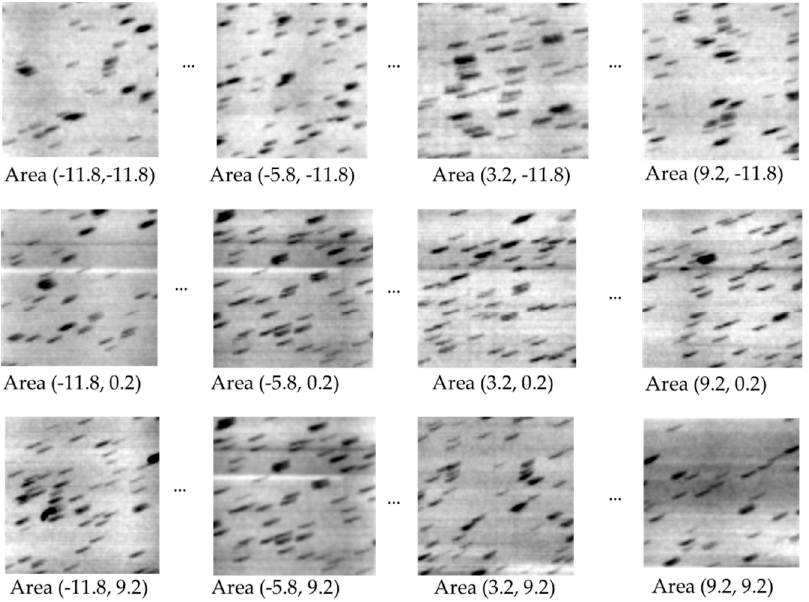
Figure 3. Illustration of how the in-plane tilt angle of the point markers varied with their locations in the field of view. The markers are glass microbeads. An array of reconstructed small areas of 1.4 × 1.4 mm size are shown, which are distributed on a rectangular grid across the full field-of-view. The numbers under each area are the x and y coordinates of the grid point in the sample coordinate system. The slices are off focus for the beads, such that each bead is defocused into a short line segment. The line segments are straight but tilted. The tilt is an effect of the deviations of the sample stage movement. The dependence of the tilt angle on the location of the beads provides sufficient information for estimating the 3D geometry of the scan.